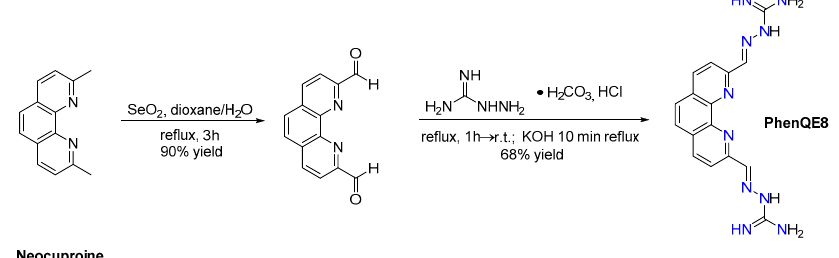
Scheme 1. Synthetic route for compound PhenQE8.